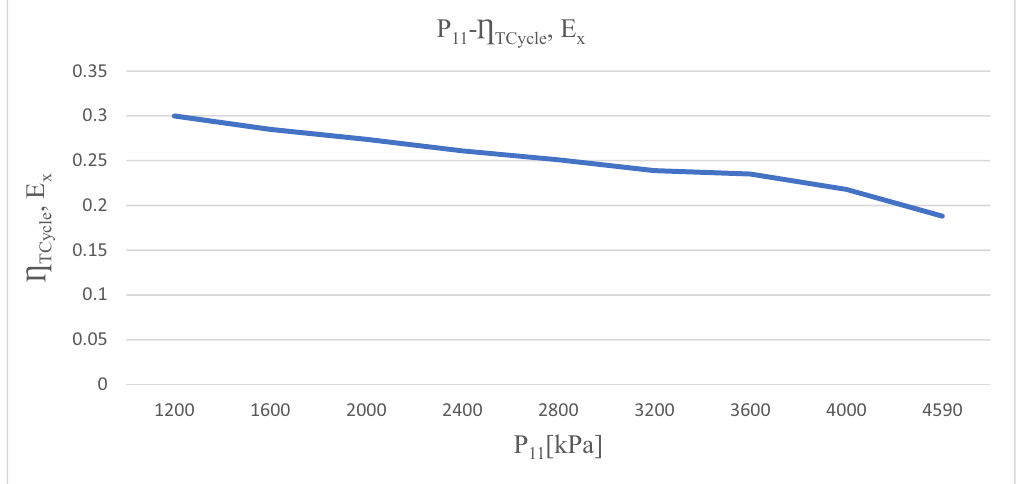
Figure 9: Exergy e ffi ciency curve of the entire cycle obtained for di ff erent outlet pressures at which the fi rst - stage compressor of the vapor compression three - stage cascade cryogenic cycle can